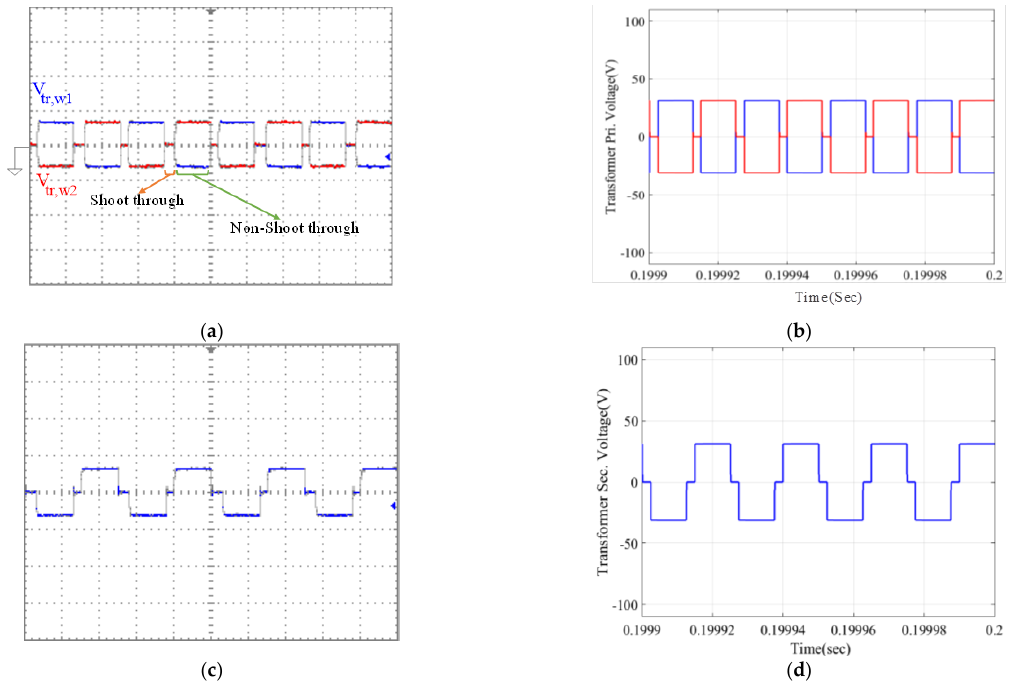
Figure 16. Simulation and experimental results for inductor currents: ( a ) experimental results for I L1 (Amp/div = 1 A, Time/div = 10 µs), ( b ) simulation results for I L1 , ( c ) experimental results for I L2 (Amp/div = 1 A, Time/div = 10 µs) and ( d ) simulation results for I L2 .